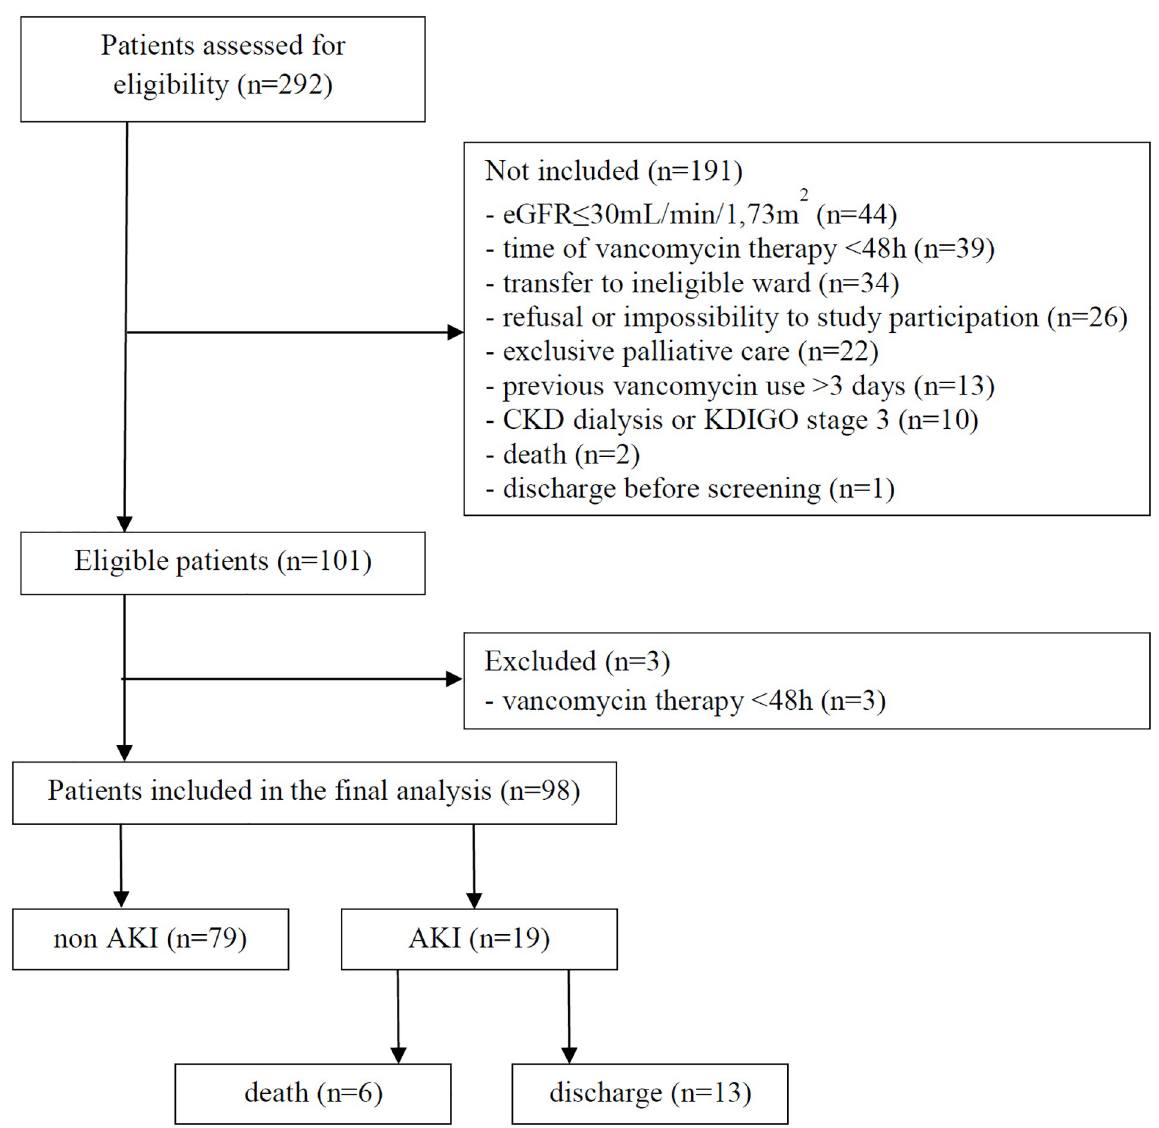
Fig 1. Flowchart for patient selection. eGFR, estimated glomerular filtration rate; KDIGO, Kidney Disease Improving Global Outcomes; CKD, chronic kidney disease; AKI, acute kidney injury.